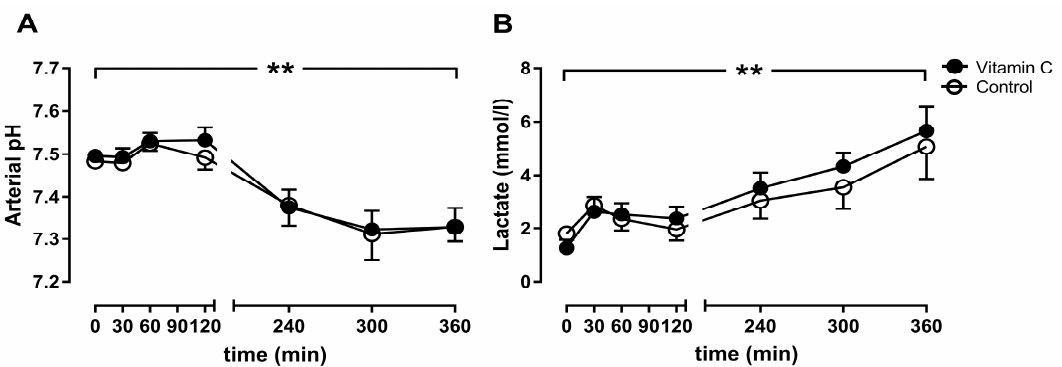
Figure 3. The arterial pH value (A) and the lactate Concentration (B). ** p < 0.01 effect of time for both groups.